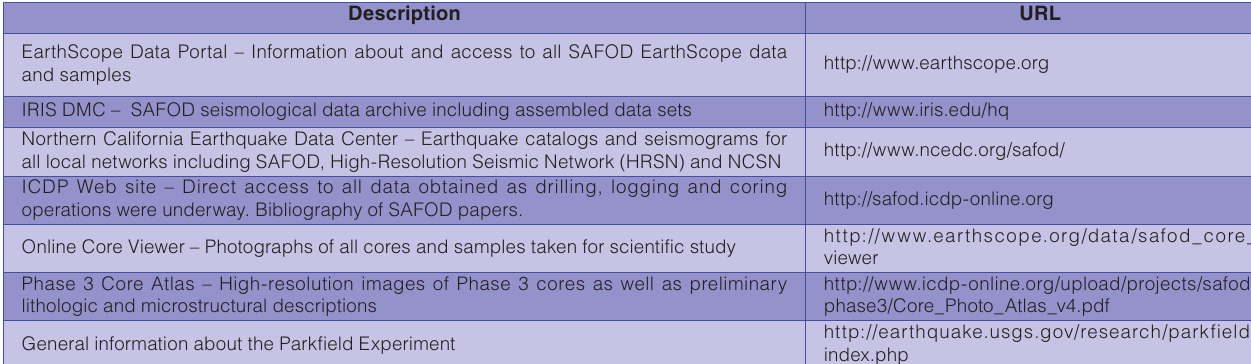
Table 1. Accessing SAFOD Data Online. Description